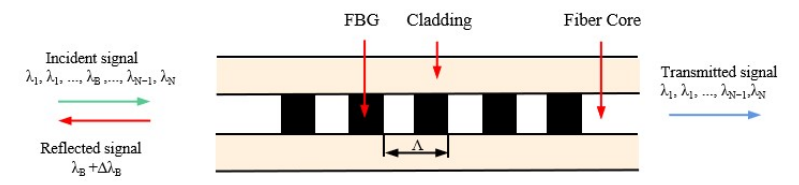
Figure 7. Structure and principle of FBG [52].